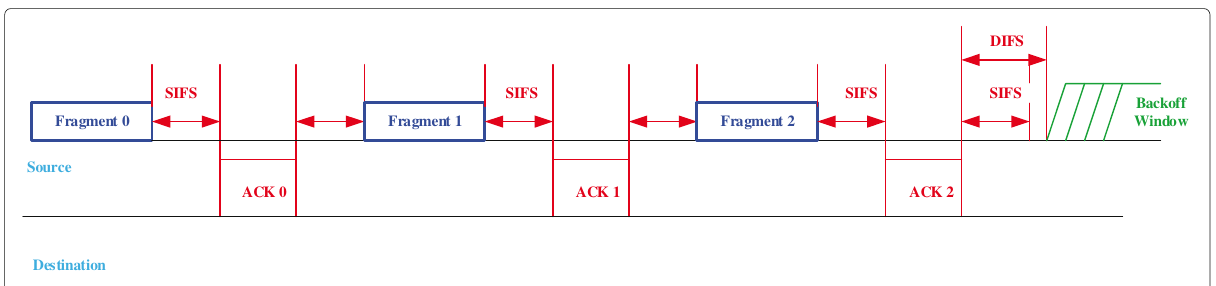
Fig. 8 Transmission procedure of a multiple-fragment MSDU